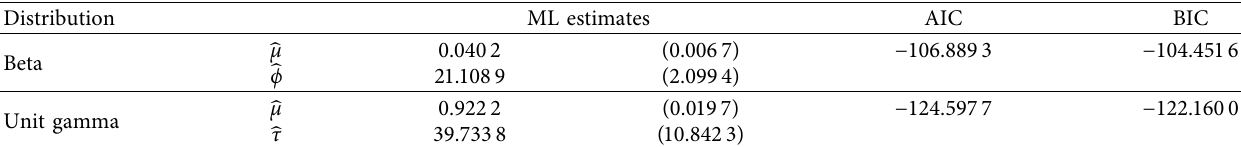
Table 5: Parameter estimates with standard errors (in parentheses) and goodness-of-fit statistics for the proportion of days between successive fire outbreaks and proportion of losses.